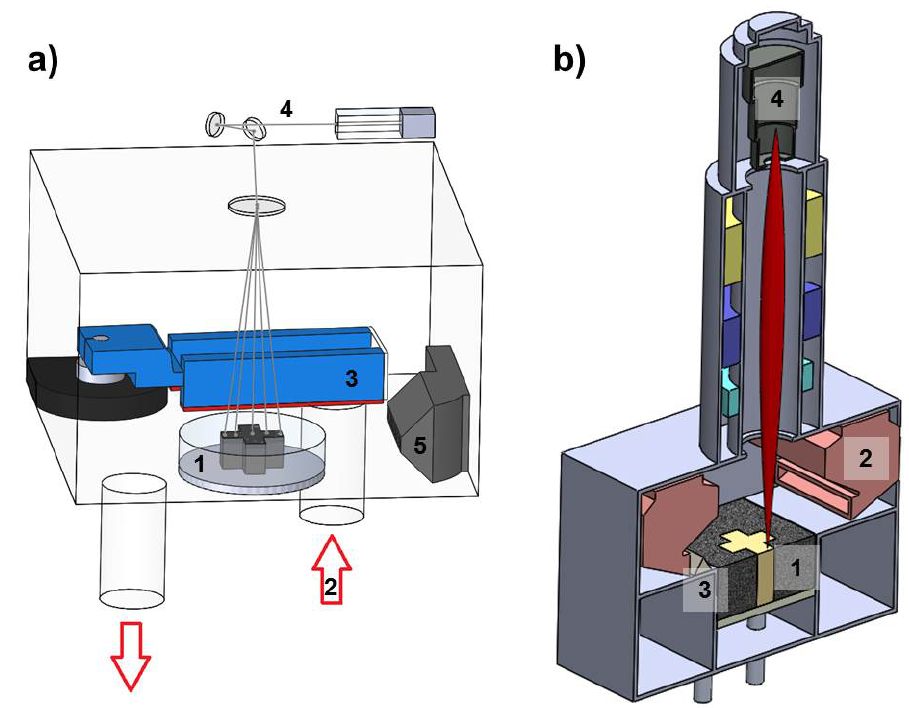
Figure 1. The schemes of ( a ) Selective Laser Melting (SLM) and ( b ) Electron Beam Melting (EBM) machines; 1, an object building platform; 2, a feed container; 3, a deposition unit; 4, a power source; 5, an argon flow nozzle.